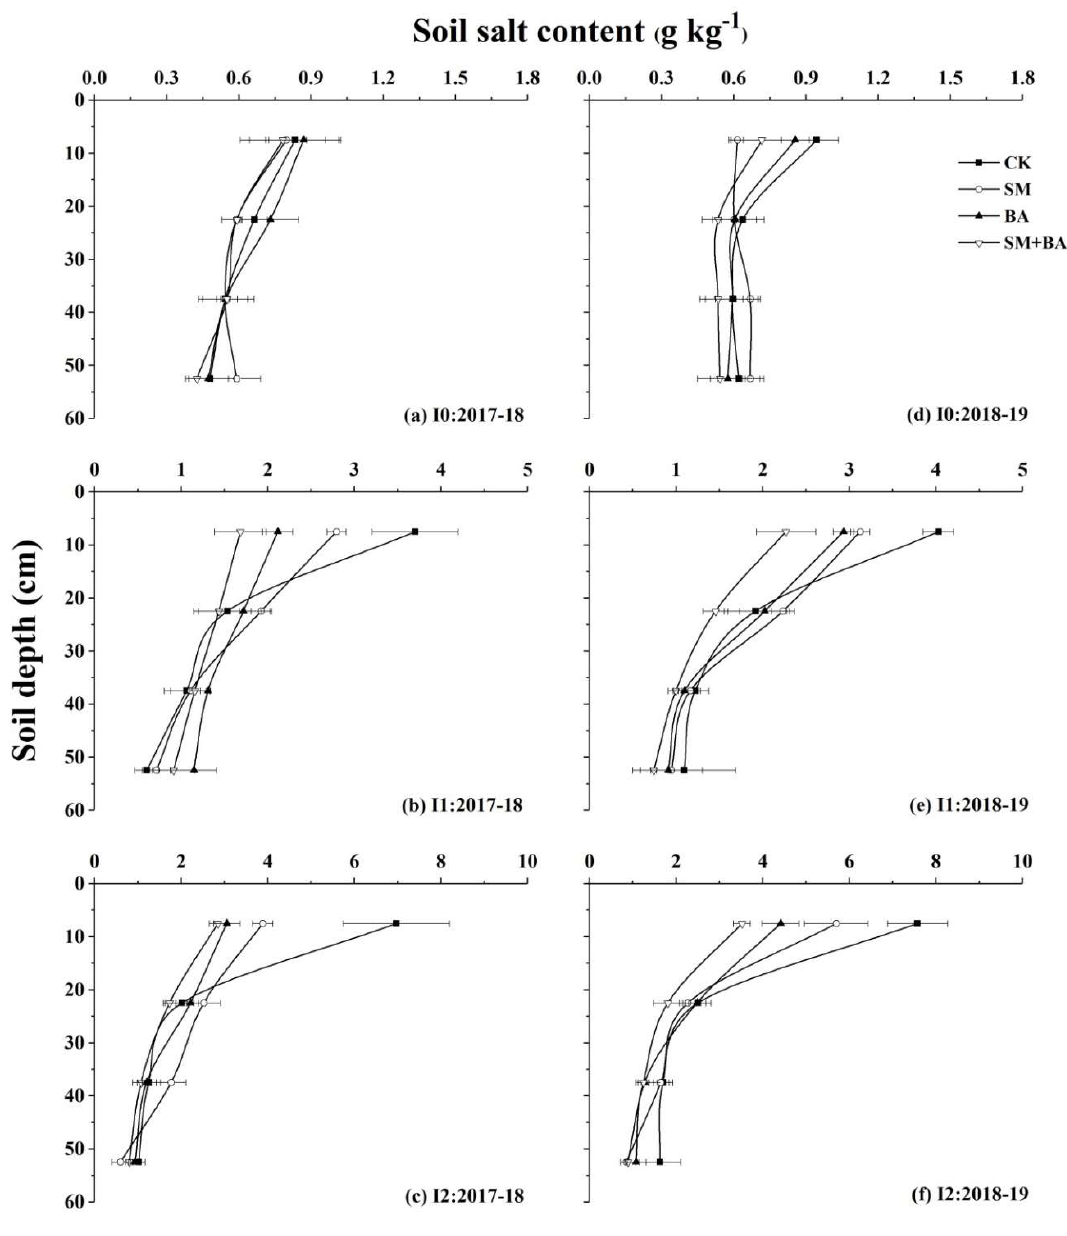
Figure 4. Vertical distribution of soil salt content within the 0–60 cm soil profiles under different straw-returning modes and irrigation water salinity levels at winter wheat harvest during the 2017–2018 and 2018–2019 growing seasons, respectively. The values are means of three replications ± standard deviation. CK: no straw-returning, SM: straw mulching, BA: biochar amendment, SM+BA: straw mulching with biochar amendment; I0, I1, and I2 indicate an irrigation salinity of 0.47 dS m − 1 , 3.25 dS m − 1 , and 6.75 dS m − 1 , respectively.